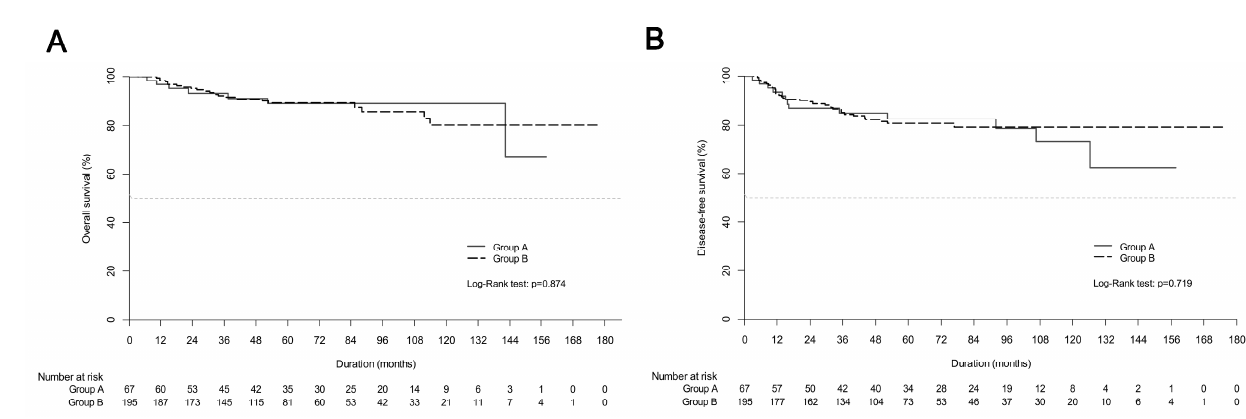
Figure 1. Kaplan-Meier estimates of ( A ) overall survival curves and ( B ) disease-free survival curves between definitive chemoradiotherapy (group A) and upfront radical hysterectomy followed by tailored adjuvant therapy (group B) in the entire cohort. Table 2. Univariate and multivariate analysis of factors for overall survival.